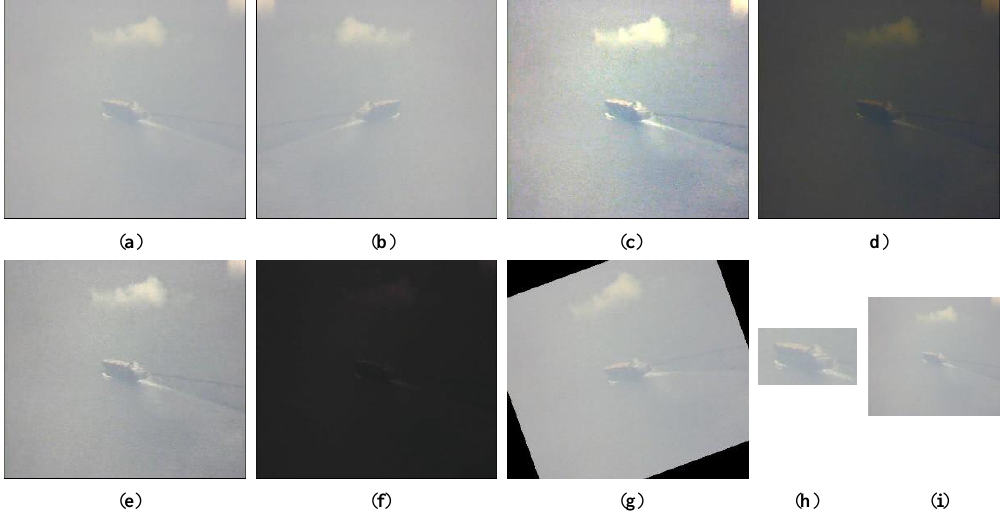
Figure 4. The image augmentation of the training set. ( a ) Original image; ( b ) Horizontal flipping; ( c ) Contrast adjustment; ( d ) Brightness adjustment; ( e ) Saturation adjustment; ( f ) Hue adjustment; ( g ) Random rotation; ( h ) Random cropping; ( i ) Random scaling.